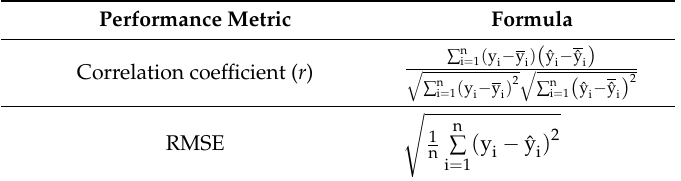
Table 3. The performance metrics for the forecasting model.